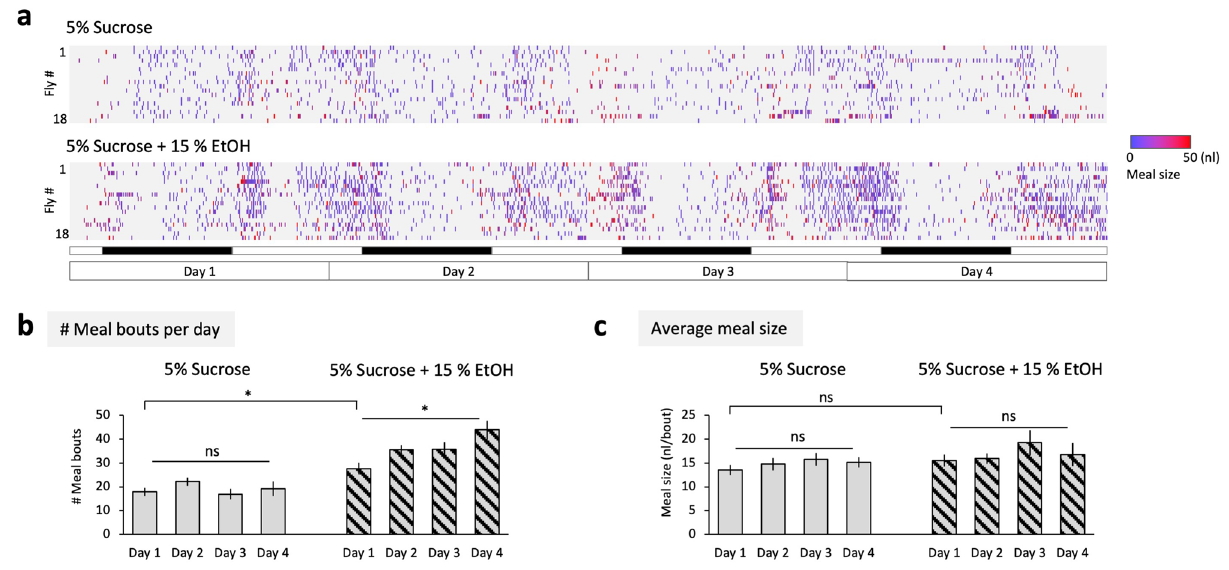
Figure 2. Escalation of repeated intake of ethanol. ( a ) Raster plots of meal-bouts of 5% sucrose solution (upper) and 5% sucrose supplemented with 15% ethanol (lower). Flies are offered with both solution similar to Fig. 1. Note that flies are measured individually not to mix up the consumption of multiple flies. Level of meniscus is measured every 5 minutes and the drop bigger than mean + 2*SD evaporation is defined as a meal bout. Rows and columns respectively indicate individual flies and time bins, and the open and filled open boxes below indicate light and dark cycle (12–12 h). Size of each meal is shown with color as shown on the right. ( b ) The number of detected meal bouts per day. 5% sucrose: F (2.018, 34.30) = 1.408, P = 0.2585, n = 18 (one-way repeated- measures ANOVA); 5% sucrose + 15% EtOH: F (1.669, 28.38) = 7.710, P = 0.0034, n = 18 (one-way repeated-measures ANOVA). 5% sucrose vs 5% sucrose + 15% EtOH on the day 1: t = 2.698, P = 0.0152, n = 18 (paired t -test). ( c ) Average meal size. 5% sucrose: F (2.452, 41.68) = 0.9641, P = 0.4047, n = 18 (one-way repeated-measures ANOVA). 5% sucrose + 15% EtOH: P = 0.0719, n = 18 (Friedman test). 5% sucrose vs 5% sucrose + 15% EtOH on the day 1: P = 0.1187, n = 18 (Wilcoxon test). Bar graphs: mean ± SEM. *: P <